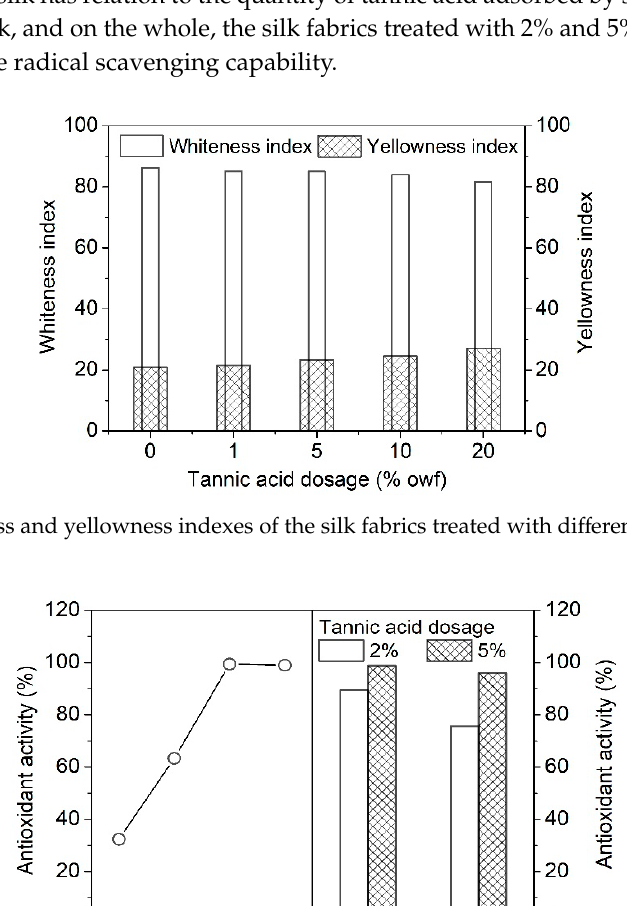
Figure 7. Whiteness and yellowness indexes of the silk fabrics treated with different concentrations of tannic acid.